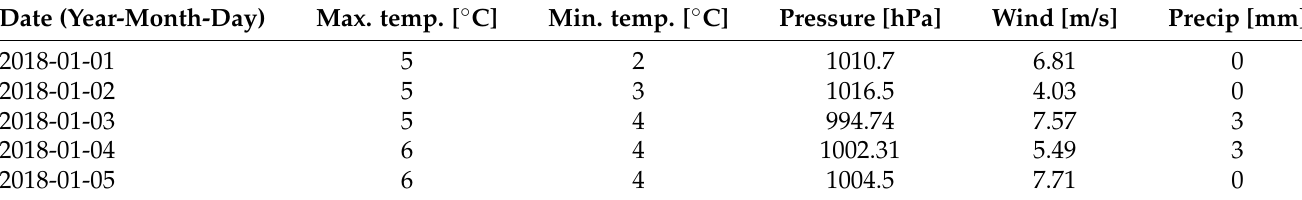
Table A16. Examples of the weather service forecast for Szczecin city from 1 January 2018 to 31 December 2020.